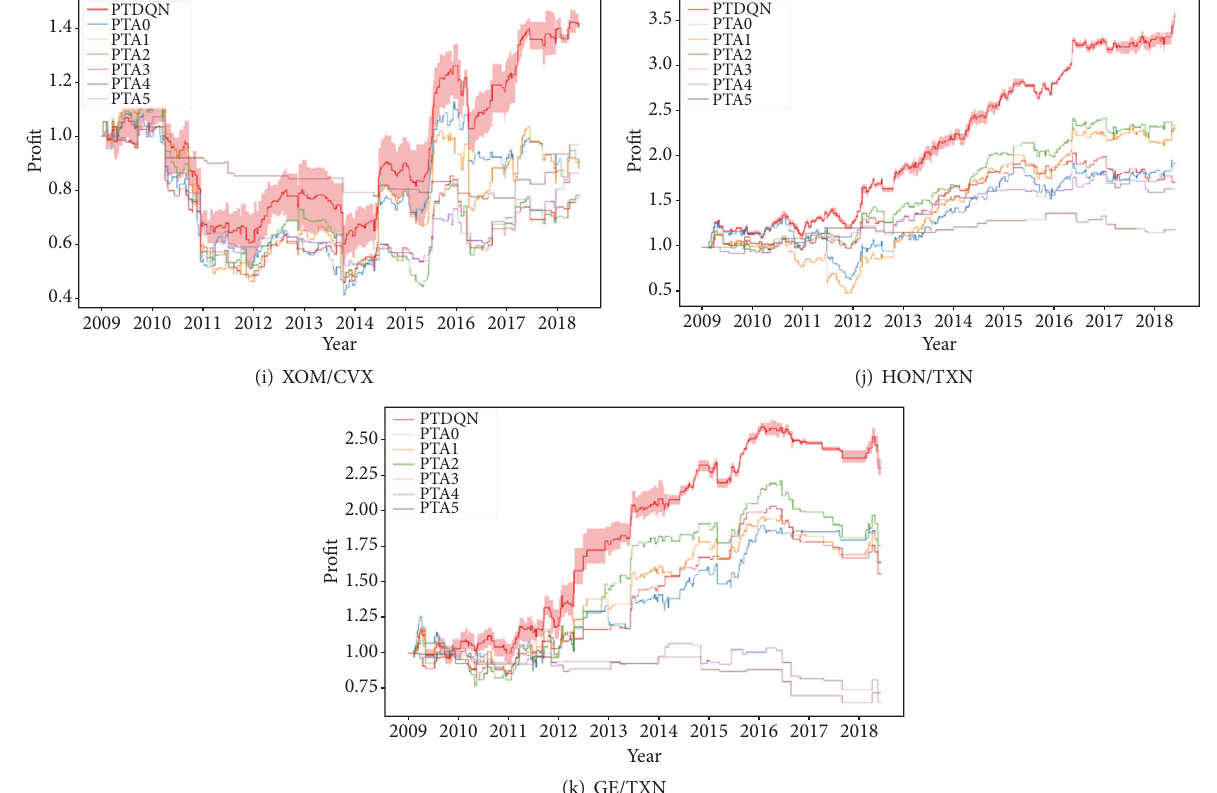
Figure 11: Average top-5 profits of PTDQN and PTA0 to PTA5 using TLS with the test